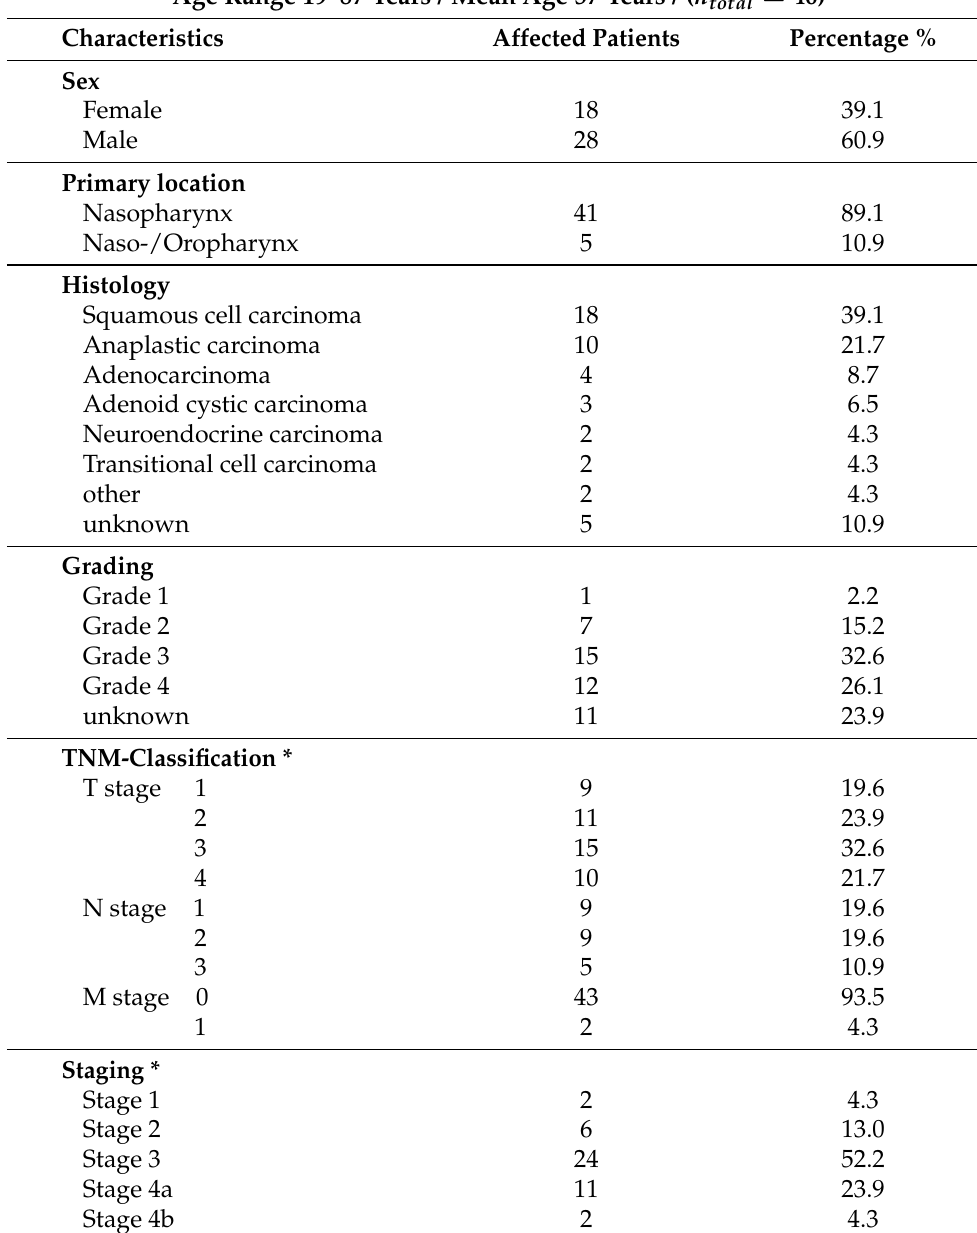
Table 1. Characteristics of the study population. * One patient had an angiocentric nasal T-cell lymphoma stage